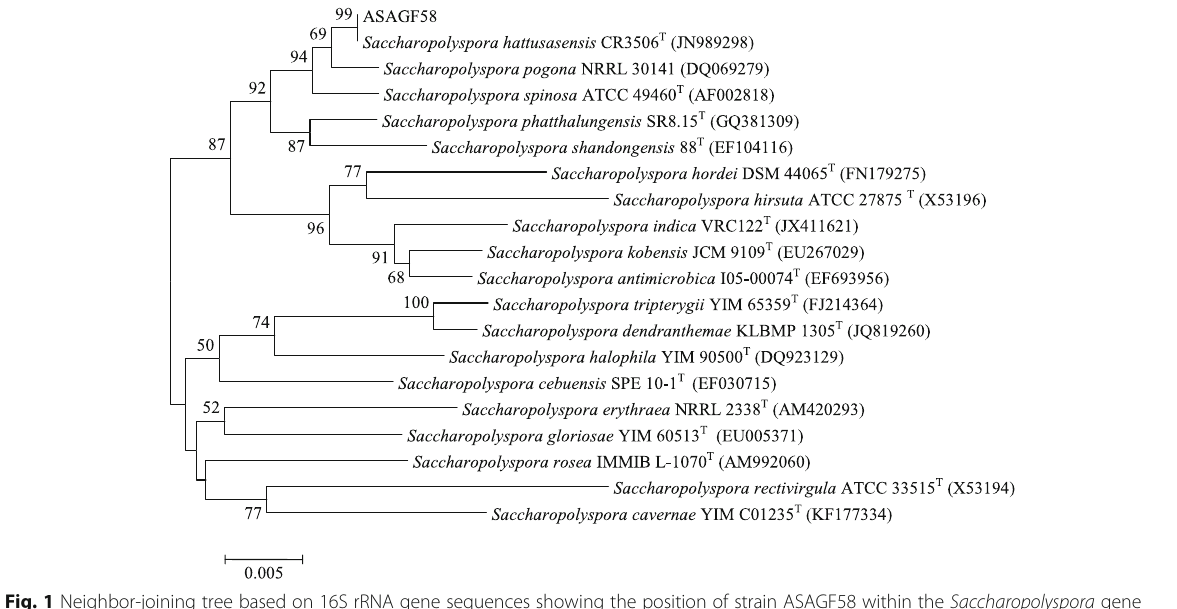
Fig. 1 Neighbor-joining tree based on 16S rRNA gene sequences showing the position of strain ASAGF58 within the Saccharopolyspora gene tree. The length of the 16S rRNA gene sequences used in the phylogenetic analysis was 1296 bp. Numbers at the nodes indicate levels of bootstrap support (%); only values > 50% are shown. GenBank accession numbers are given in parentheses. Bar 0.005 substitutions per